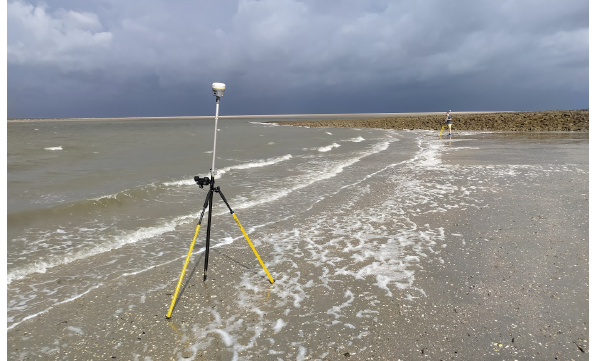
Figure 3. GNSS survey during the F-SAR flight mission. Direction of view towards north. Note the (in this case already scattered) sea foam as indicator for the WLB.